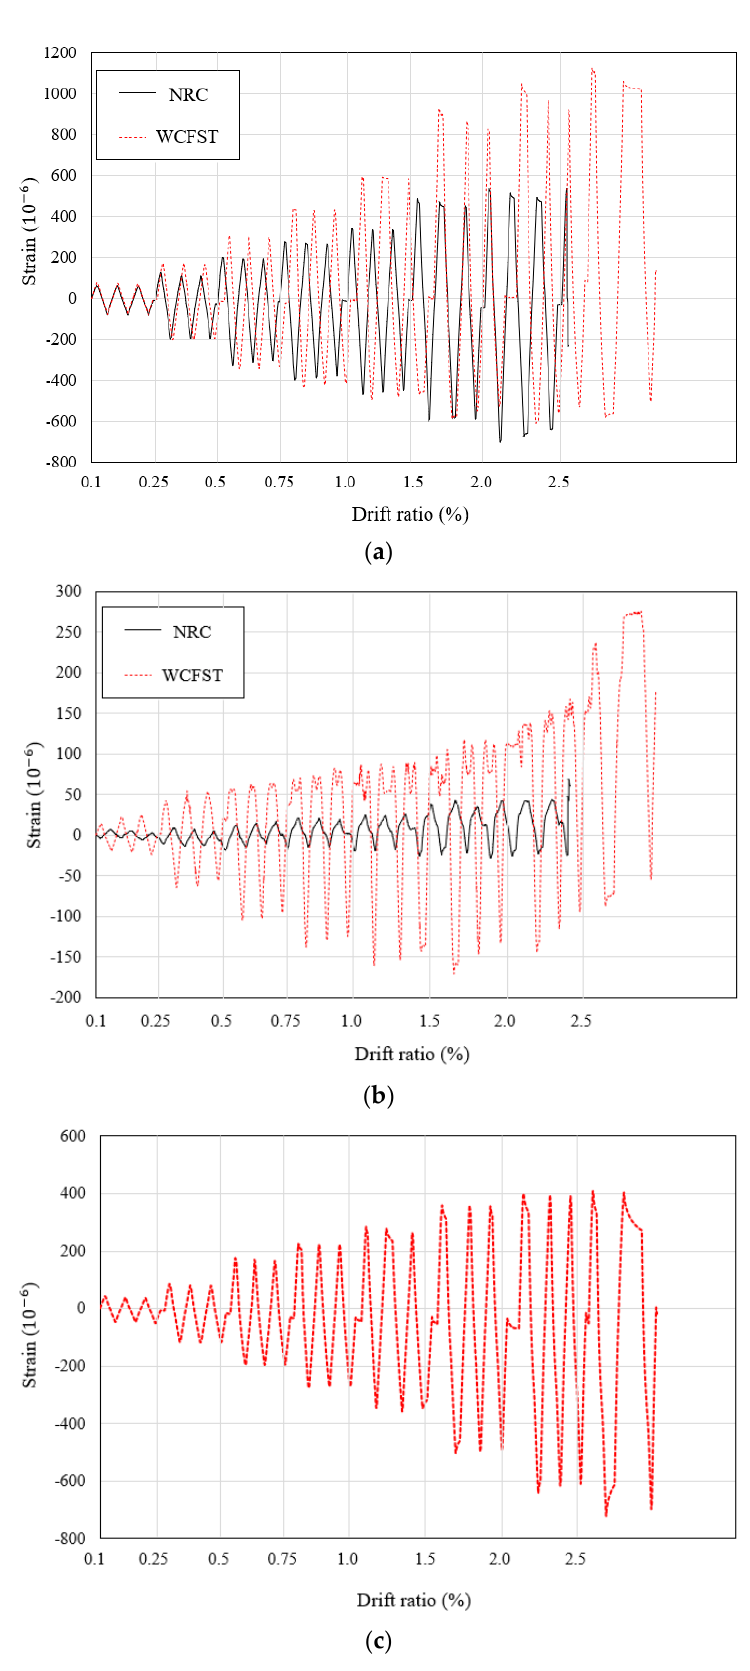
Figure 10. Strain at the end of the beam: ( a ) strain of the longitudinal steel at the end of the beam, ( b ) strain of the stirrup at the end of the beam, and ( c ) strain of the CFST frame at the end of the beam in the WCFST specimen.